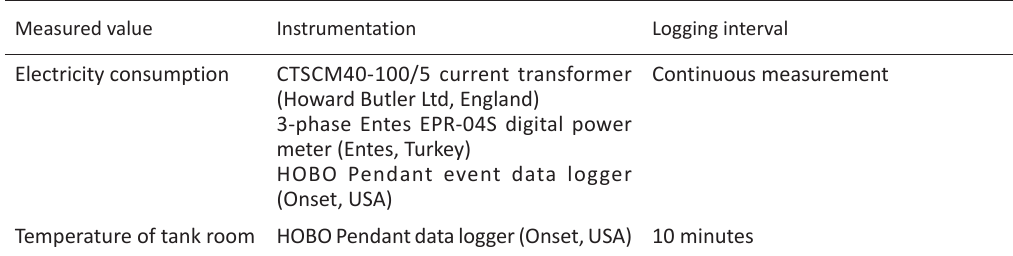
Table 2. Instrumentation used in measurements Measured